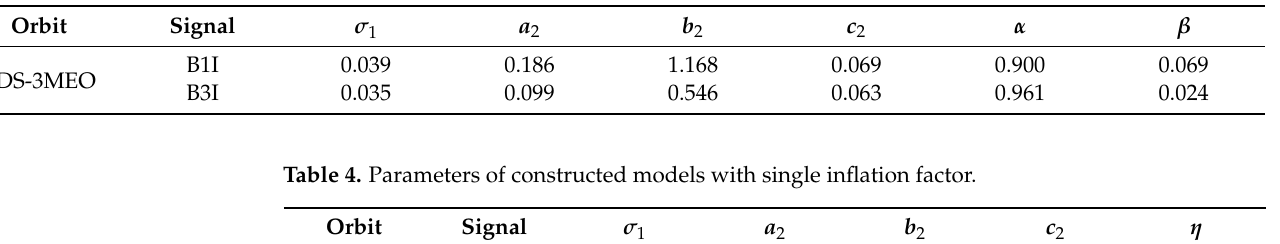
Table 3. Parameters of constructed models with two inflation factors.